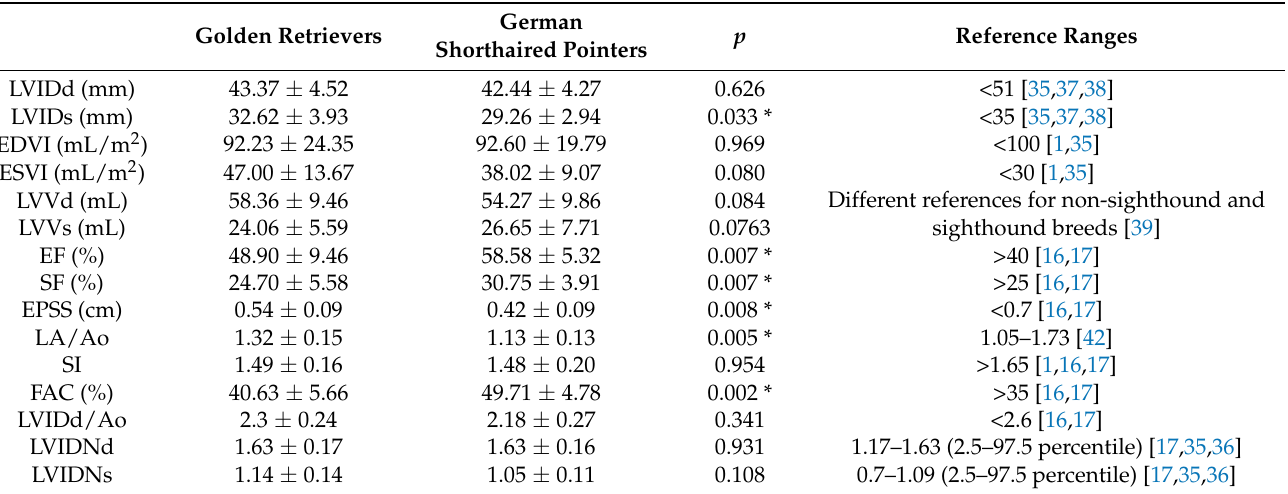
Table 3. Echocardiographic variables in the Golden Retrievers and German Shorthaired Pointers, their comparisons, and the reference ranges proposed in the